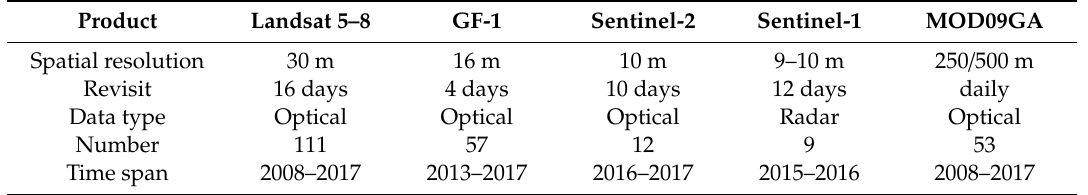
Table 1. Details of the satellite remote sensing data used in this study.